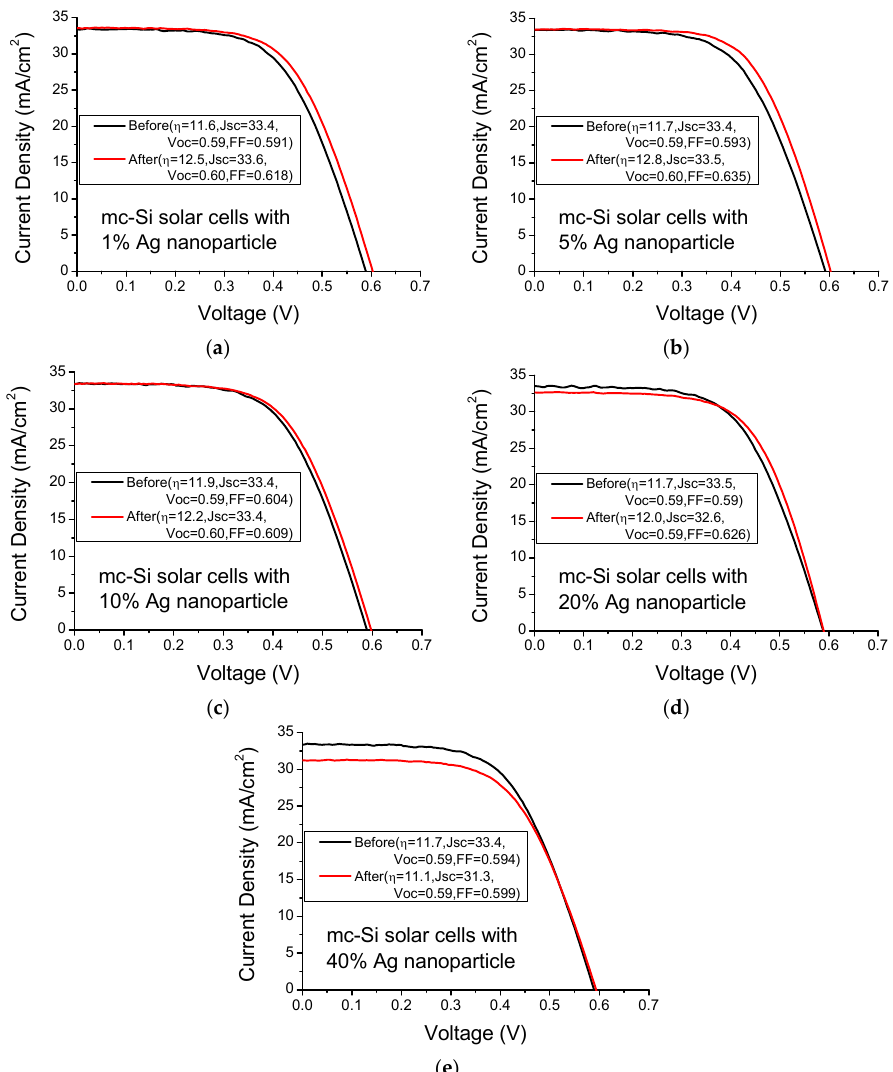
Figure 5. Current ‐ voltage curves of mc ‐ Si solar cells with various Ag nanoparticle concentrations of Figure 5. Current-voltage curves of mc-Si solar cells with various Ag nanoparticle concentrations of ( a ) 1%; ( b ) 5%; ( c ) 10%; ( d ) 20% and ( e ) 40 % under AM1.5 illumination. ( a ) 1%; ( b ) 5%; ( c ) 10%; ( d ) 20% and ( e ) 40% under AM1.5